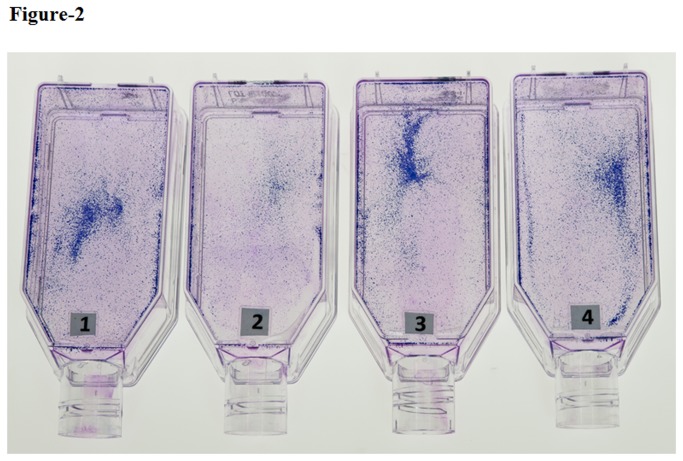
Representative Giemsa stained flasks showing the effect of β-amyloid1-42, Ashwagandha and Ashwagandha plus β-amyloid1-42 on SK-N-MC cell line1. Control, 2. β- Amyloid 1-42 treated, 3. Ashwagandha treated and 4. Ashwagandha plus β- Amyloid1-42 treated.